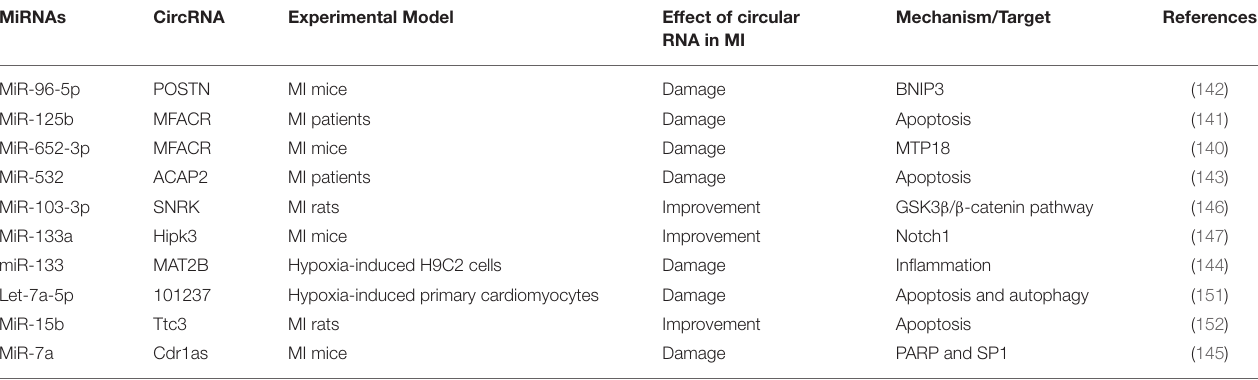
TABLE 8 | Summary of studies on circular RNAs as sponges of miRNA during MI in the past 5 years.